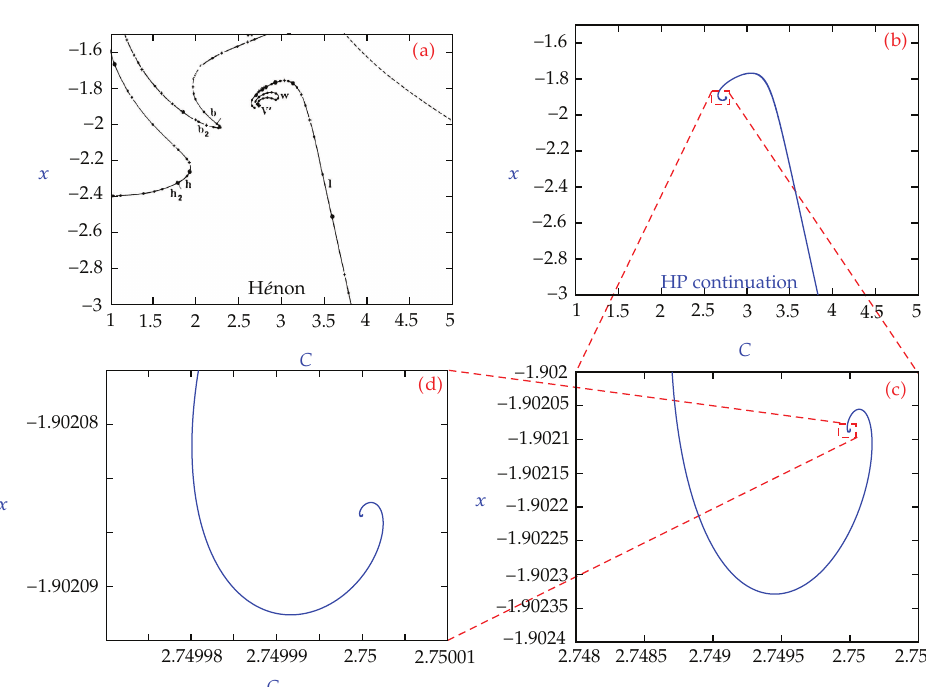
Figure 4: Family of periodic orbits for the Copenhagen problem depending on the coordinate x and the Jacobi constant C . Picture (cid:3) a (cid:4) is extracted from Exploration num´erique du probl`eme restreint. I. Masses ´egales; orbites p´eriodiques , H´enon (cid:5) 44 (cid:6) ; Picture (cid:3) b (cid:4) shows the same curve obtained with the method described above. Bottom: magnifications of the squared regions showing the spiral